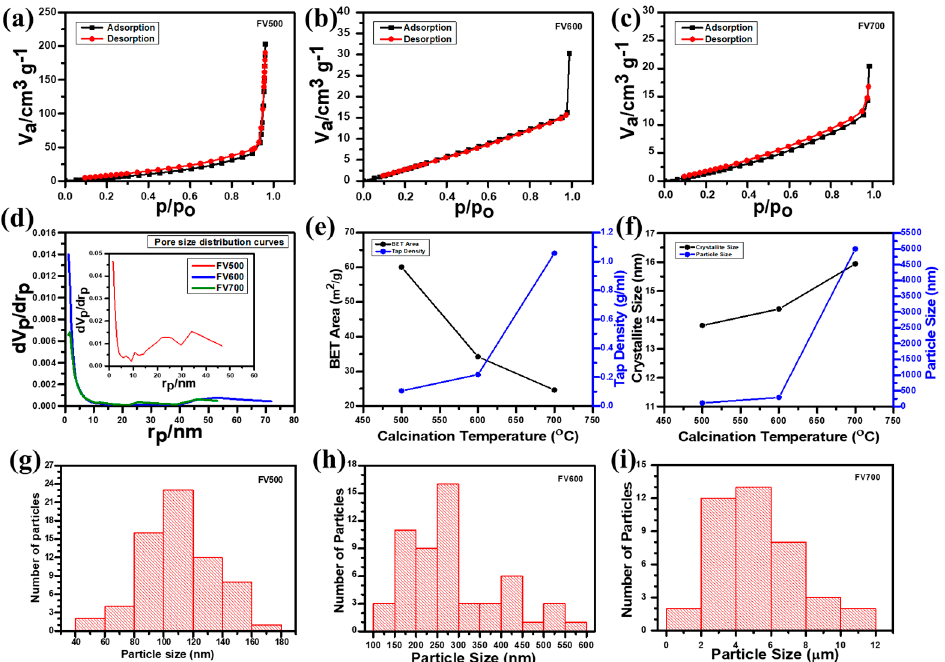
Figure 2. N 2 adsorption/desorption curves of ( a ) FV500, ( b ) FV600, and ( c ) FV700, respectively. ( d ) pore size distribution curves of FV500, FV600, and FV700. The correlation between ( e ) crystallite size, particle size, and ( f ) BET area, and tap density at different calcination temperatures (FV500, FV600, and FV700). The particle size distribution curves calculated by ImageJ software of ( g ) FV500, ( h ) FV600, and ( i ) FV700, respectively.